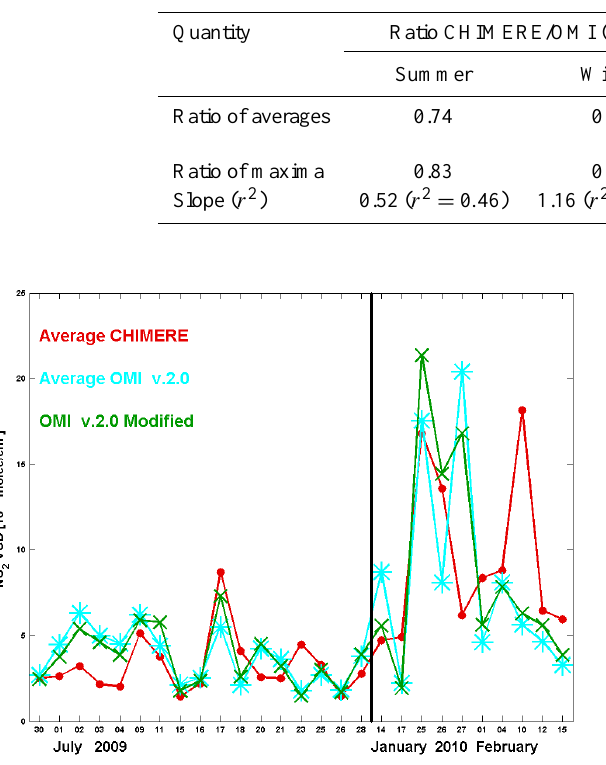
Table 3. Ratios of daily average and maximum values (CHIMERE/OMI) as well as slopes and correlation coefficients of the regression analyses for OMI observations with effective CF below 0.3.